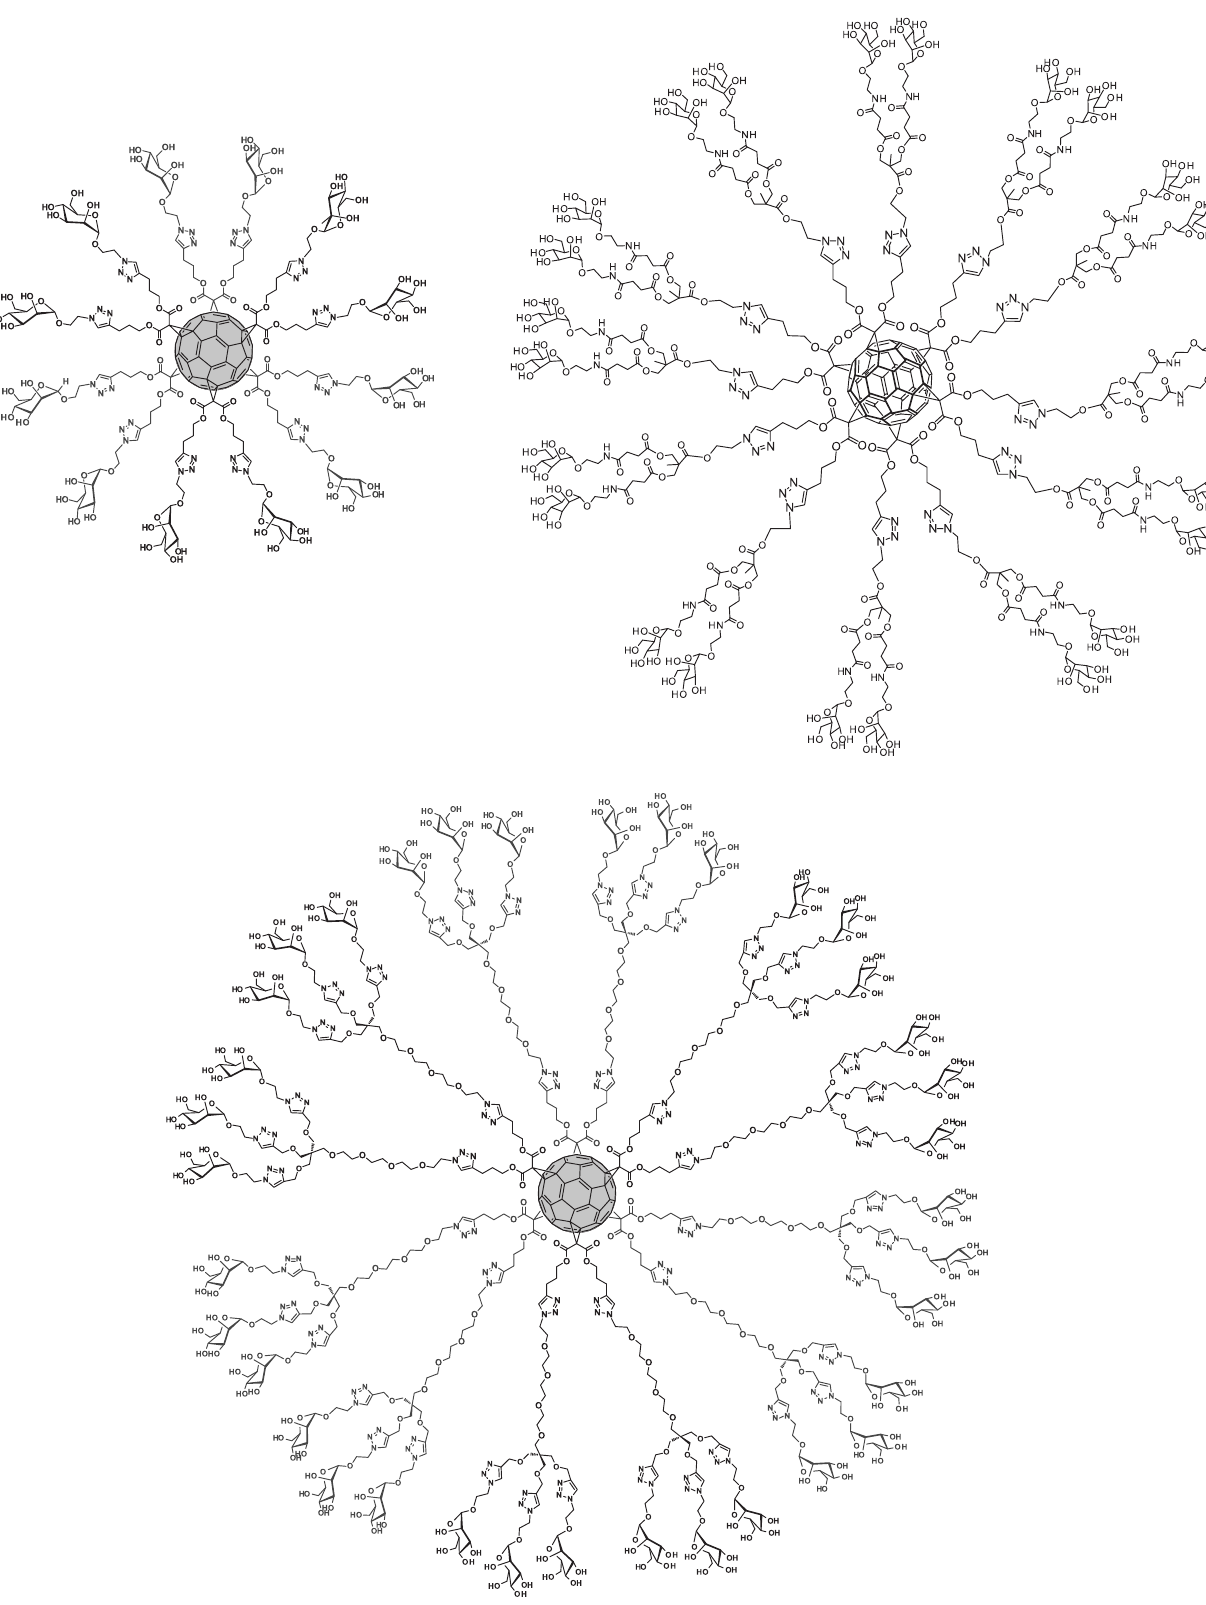
FIGURE 9 - Glycofullerenes with 12, 24 and 36